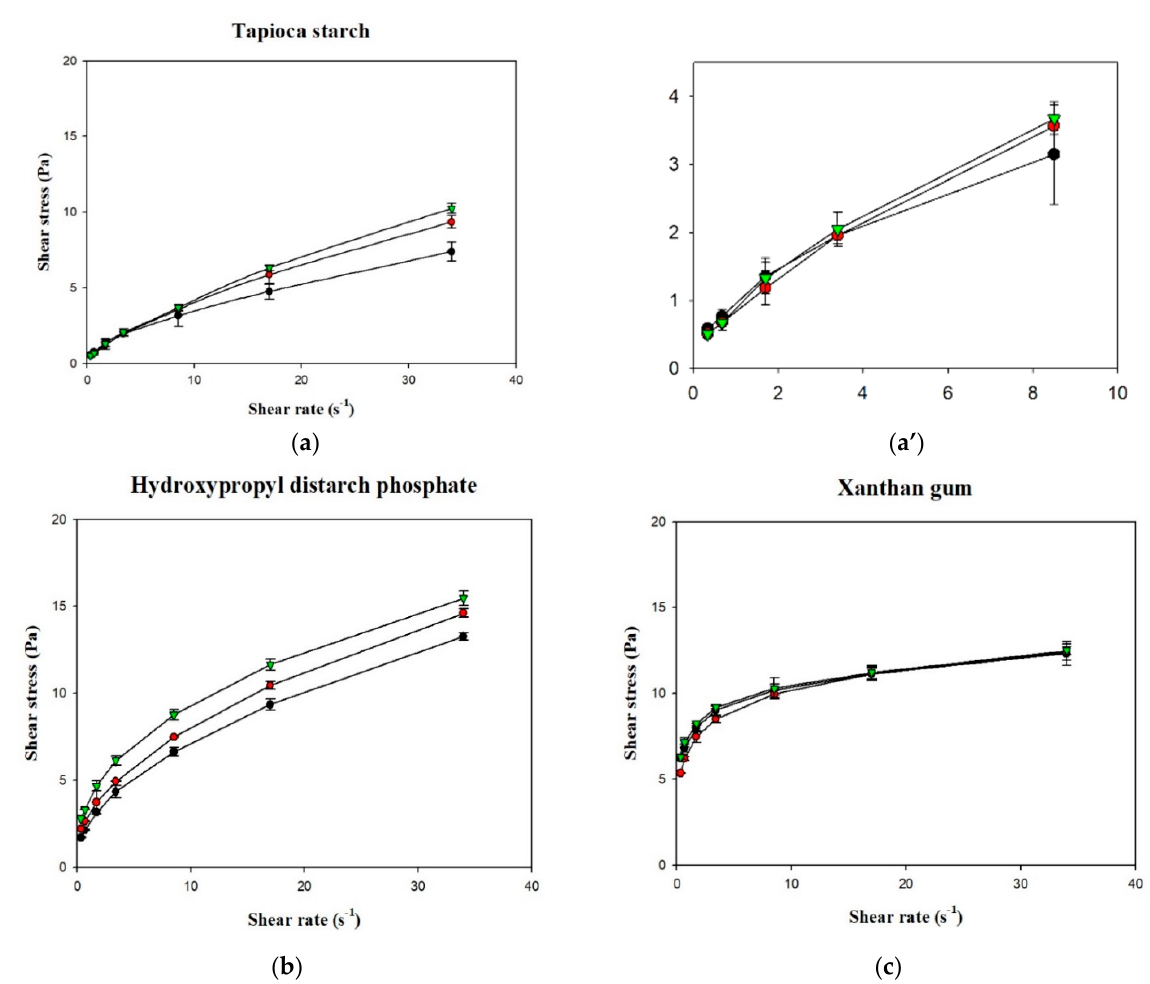
Figure 6. Shear rate-shear stress profile of different thickened beverages. Water ( ● ); sport drink ( ● ); orange juice ( ▼ ). Error bars represent standard deviations. Thickeners: ( a ) tapioca starch with a partial magnification ( a’ ); ( b ) hydroxypropyl distarch phosphate; ( c ) xanthan gum. Table 3. Summary of the flow properties parameter of regression output of Herschel–Bulkley model for thickened beverages made from different commercial thickeners and fluid bases *.